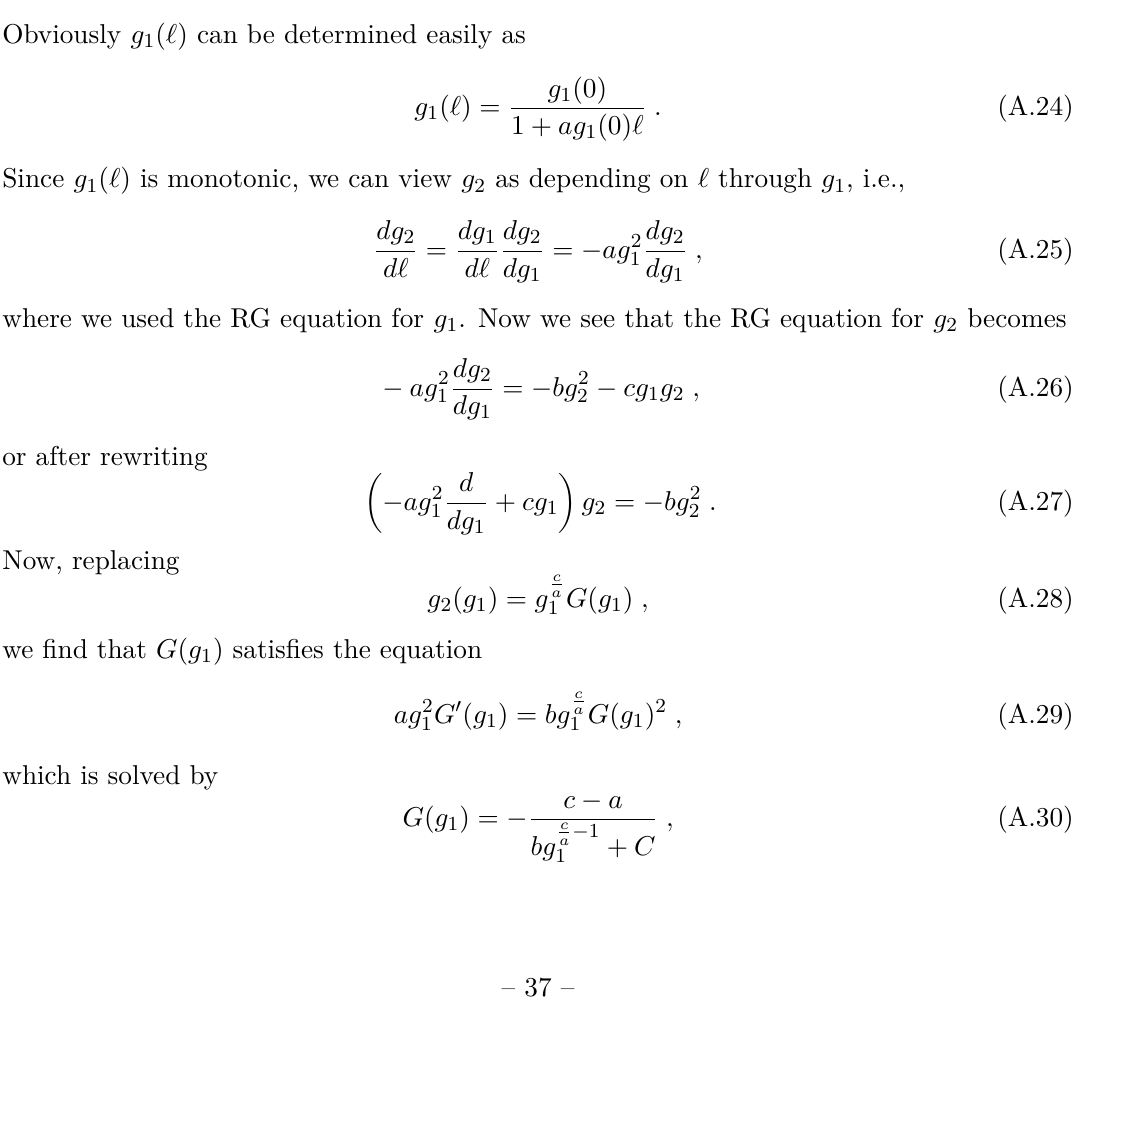
Figure 13 . The plot of the critical ratio r 0 as a function of N f defined in (A.21). For the ratio of the bare couplings λ 0 /g 0 in the shaded region the transition is 2nd